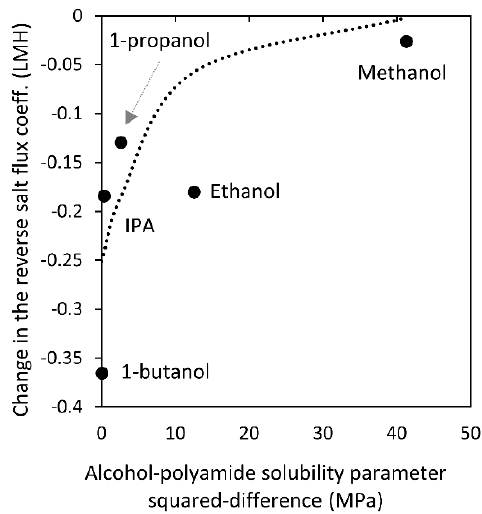
Figure 7. Calculated change in the reverse salt flux coefficient using Equation (15) versus the squared-difference in the reported solubility parameters of alcohols (Table 2) and fully-aromatic polyamide [18]. The dashed curve is a guide for the reader ′ s eye.